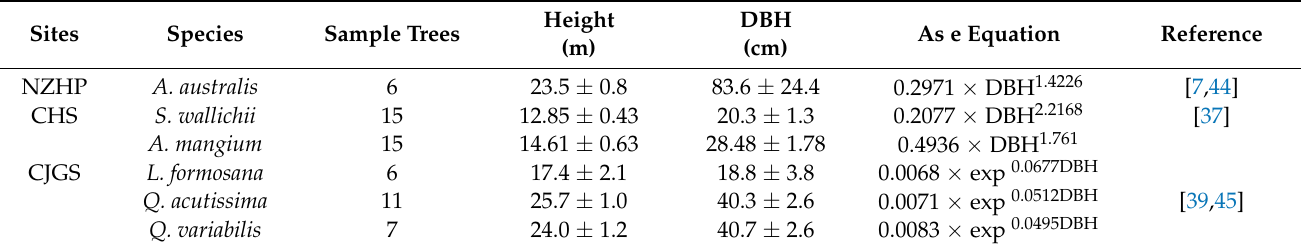
Table 3. Overview of sapwood area equations for six studied species and average tree height and tree size of sample trees at each site. Values are mean ±